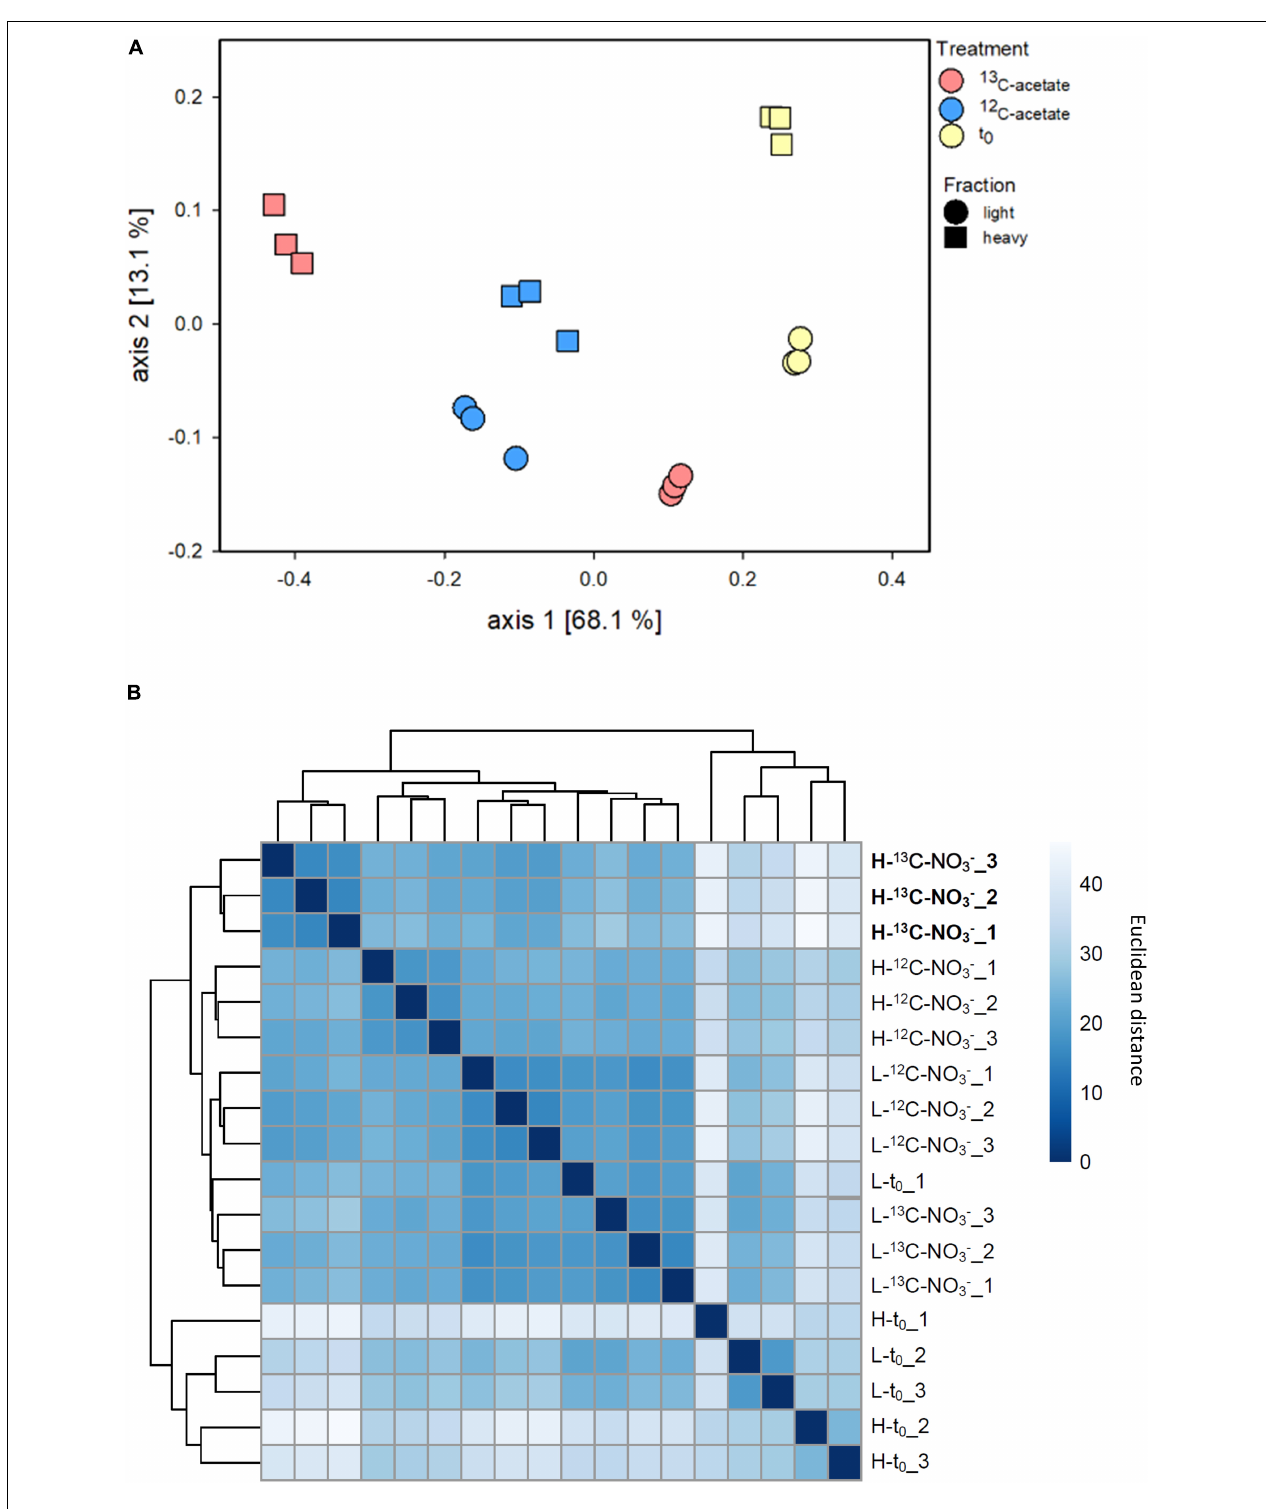
FIGURE 3 | Principal coordinates analysis (PCoA; A ) based on Bray–Curtis dissimilarity calculated from relative abundance data of bacterial species-level OTUs from density resolved 16S rRNA sequences retrieved from cryoturbated peat circle sediments prior to ( t 0 ) and after 16 days of anoxic incubation (see Figure 1 ). Hierarchical heat map clustering is presented in panel (B) . Color code indicates levels of dissimilarity. Sample code: H and L indicate heavy and light fractions, respectively; t 0 , 13 C- and 12 C- represent peat circle sediments prior to incubation, 13 C- and 12 C-acetate treatments, respectively. Numbers are indicative of replicate. Heavy fractions of treatemnts with labelled acetate are printed in bold.